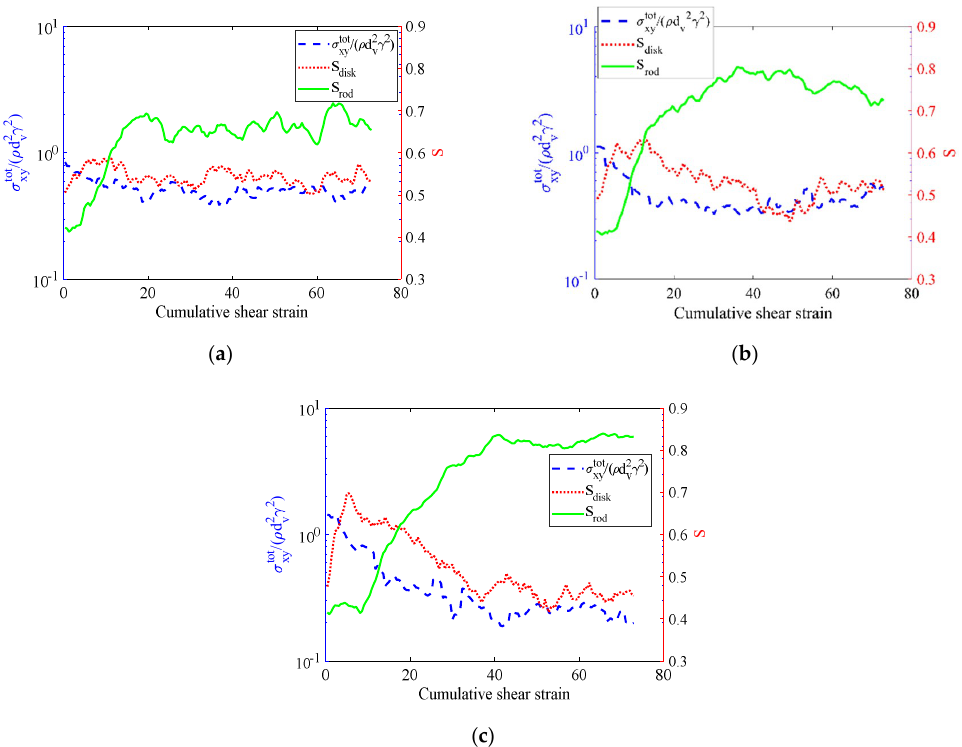
Figure 10. Evolution of normalized shear stress and order parameter S with cumulative shear strain for binary mixture flows of AR = 0.3 (disks) and AR = 6 (rods) with rods fractions ( a ) C = 0.25, ( b ) C = 0.5, and ( c ) C = 0.75. The solid volume fraction is ν = 0.5.